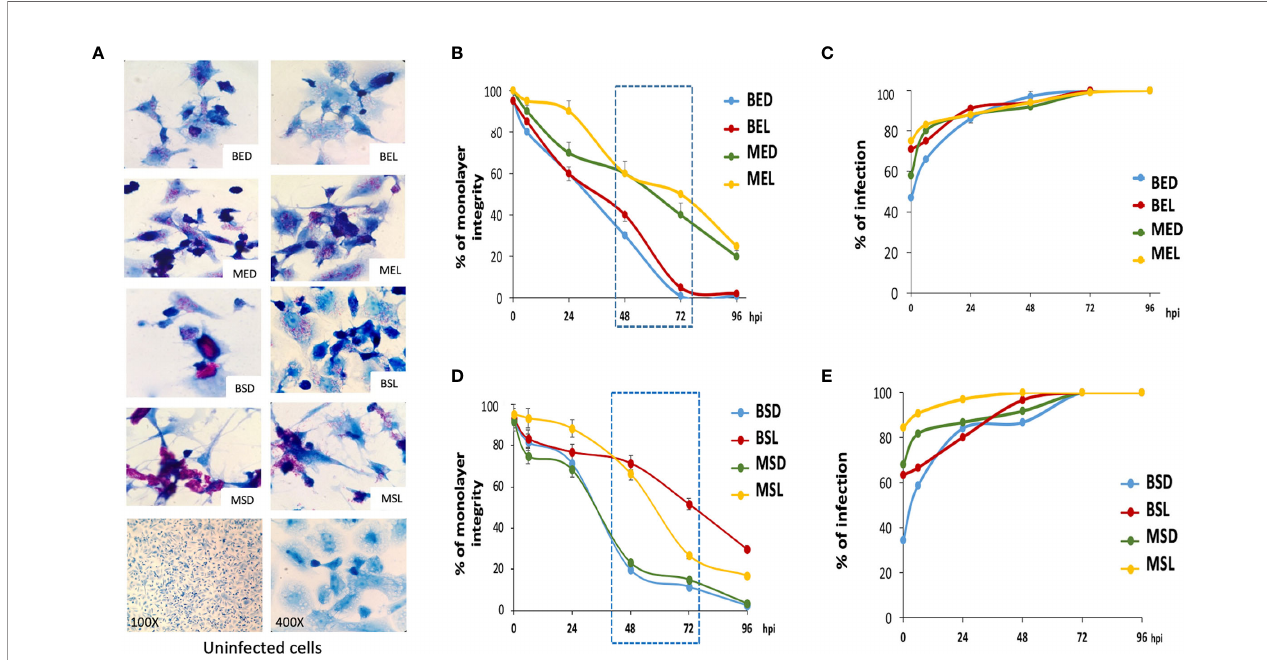
FIGURE 6 | M. bovis BCG cultured in lipids produce less damage to macrophages. THP-1 macrophages (3 × 10 5 ) were infected with wtBCG or mtBCG (strains at the exponential or stationary phase in the presence of dextrose or lipids) using a MOI of 5:1. After 4 h, cells were washed and incubated with fresh RPMI medium. Infected cells were incubated for 24, 48, 72, and 96 h and stained by Kinyoun stain. (A) Panels show representative images of infections at 48 h (400×), and control monolayers without infection. (B, D) Cell damage was reported as percentage of monolayer integrity (Helguera-Repetto et al., 2014). Production of cytoplasmic projections and cell vacuolization reported during mycobacterial entry into endothelial cells were also considered as cell damage (Baltierra-Uribe et al., 2014). (C, E) Percentages of infection were obtained by counting infected macrophages in 10 fi elds of the monolayer. wtBCG or mtBCG cultured in dextrose or lipids during the